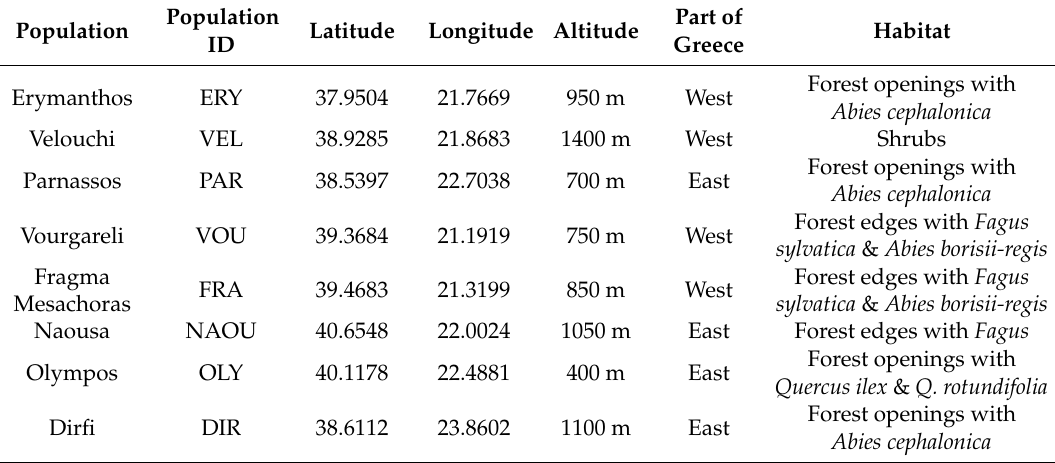
Table 1. Abbreviations used for the analyses, locality, and collection information of the Helleborus odorus subsp. cyclophyllus populations under